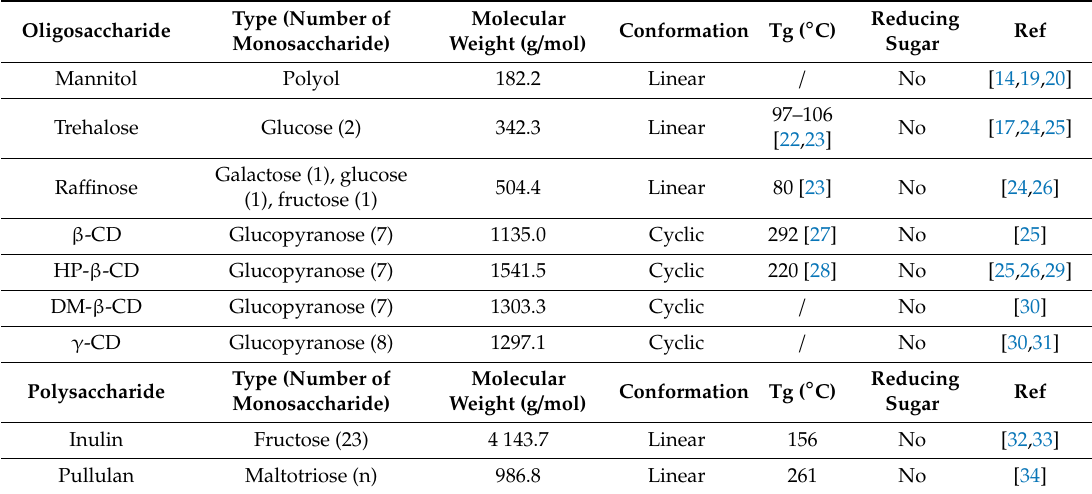
Table 1. Properties of polyol, oligosaccharides and polysaccharides used to produce the core of composite-corrugated particle powders by spray